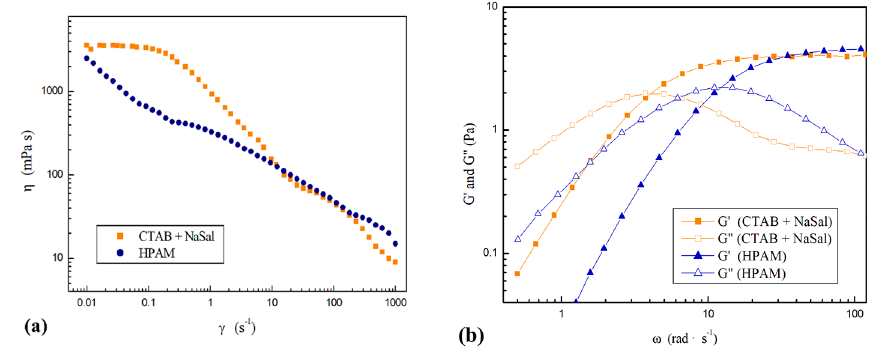
Figure 2. Viscosity η of the VES fluid and the HPAM solution as shear rates γ rising from 0.01 s − 1 to 1000 s − 1 . and ( b ) Oscillatory measurement of the storage modulus G ′ and the loss modulus G ″ .